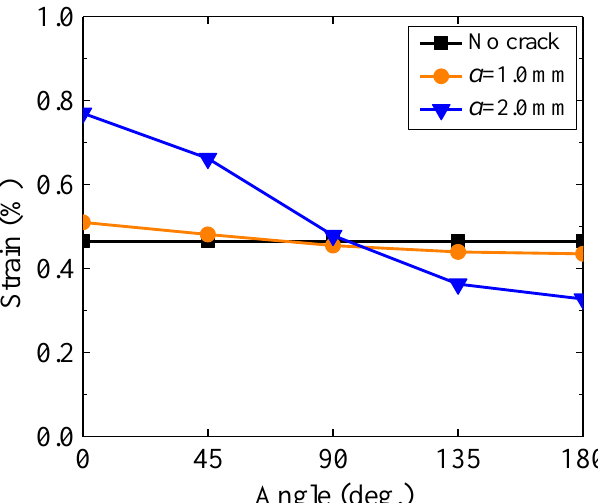
Figure 12. Variation of strain of the 10 mm part containing the crack with the angle θ of the projection of the position of extensometer on the smallest plane relative to the center line of the crack shown in Figure 11b.